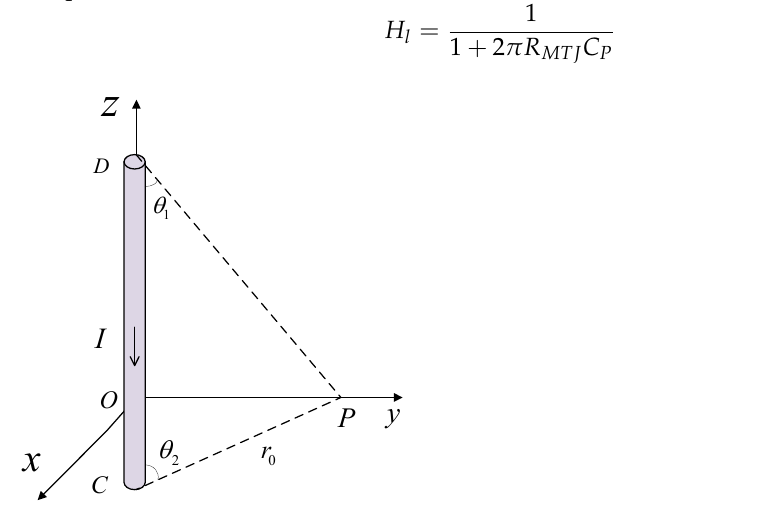
Figure 1. A schematic diagram of the magnetic field generated around a current-carrying wire.